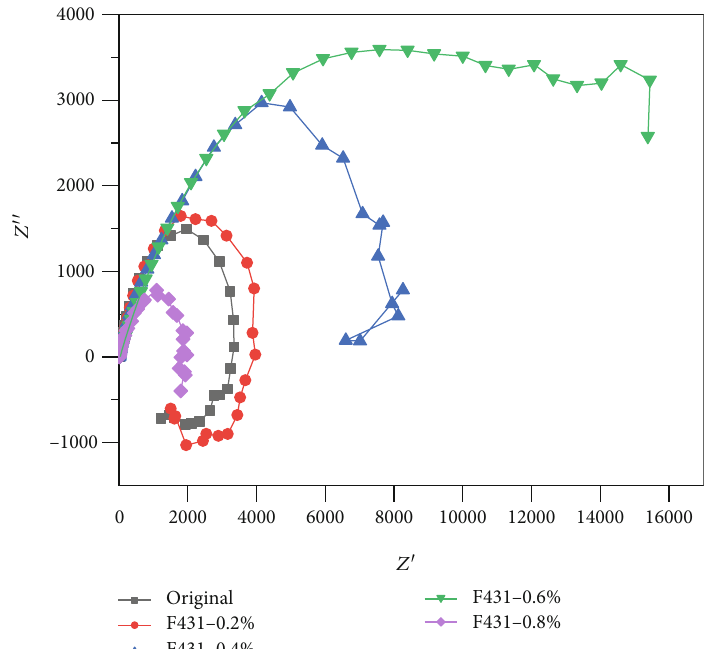
Figure 5: Nyquist of original and graphene additions of 0.2%, 0.4%, 0.6%, and 0.8% anticorrosion coatings. Original, no added graphene;